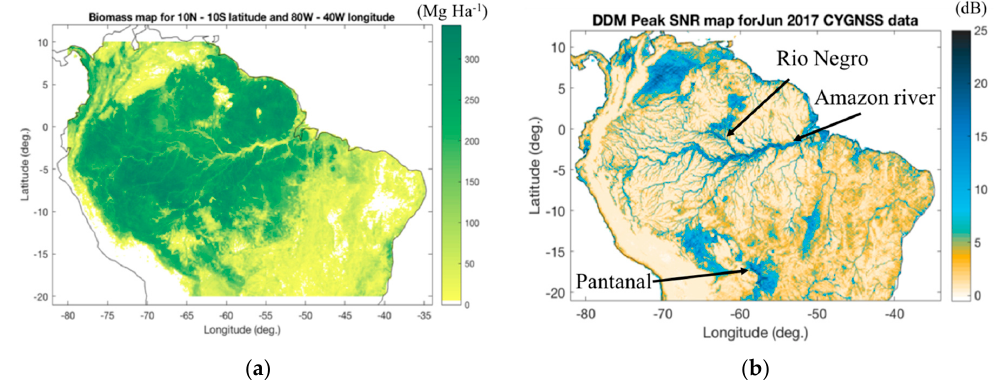
Figure 3. Sensitivity to inundation: ( a ) Global Forest Watch (GFW) Amazon Basin pantropical map of aboveground live woody biomass density (MgHa − 1 ) at 30-m resolution for the year 2000 [41]; and ( b ) CYGNSS peak SNR (dB) averaged over one month (June 2017) and gridded at 7 km × 7 km. Most of the areas with high peak SNR (in blue) are characterized as inundated. This comparison shows the sensitivity of the CYGNSS signal to inundation in areas with different levels of vegetation biomass. We utilized a biomass map of the Amazon Basin [45] to estimate vegetation density (Figure 3a) and account for CYGNSS data sensitivity to inundation under various levels of vegetation density.